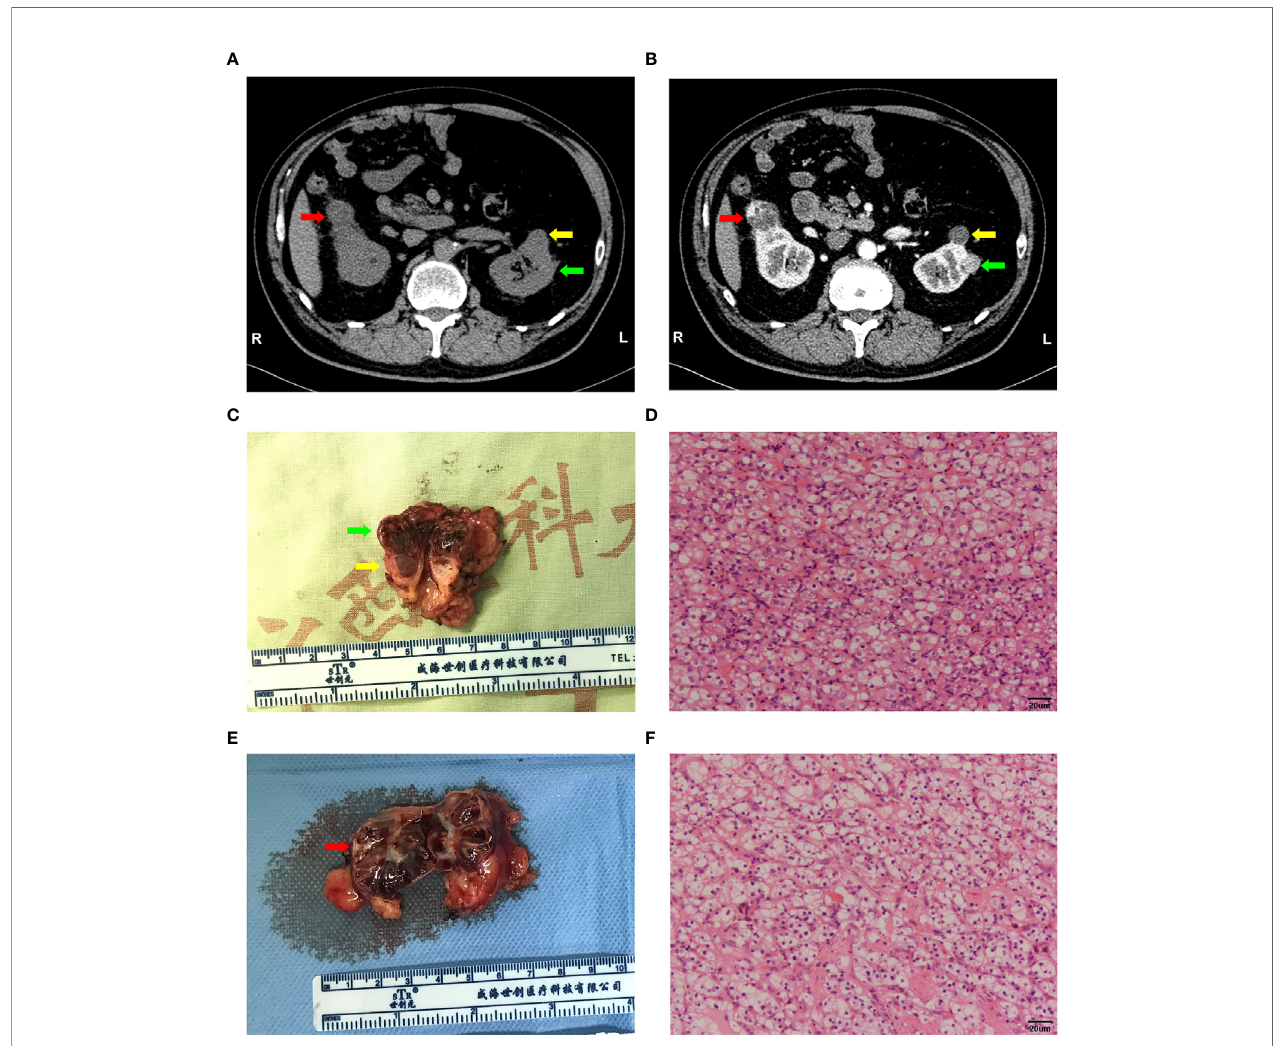
FIGURE 1 | Imaging and pathological information of this sample. (A, B) Computed tomography (CT) plain and arterial images of the bilateral tumour. Right tumour (red arrow), left tumour (green arrow) and renal cyst (yellow arrow). (C, D) General view of the left renal tumour and histological morphology of the cells by HE staining. Scale bars, 20 m m. (E, F) General view of the right renal tumour and histological morphology of the cells by HE staining. Scale bars, 20 m